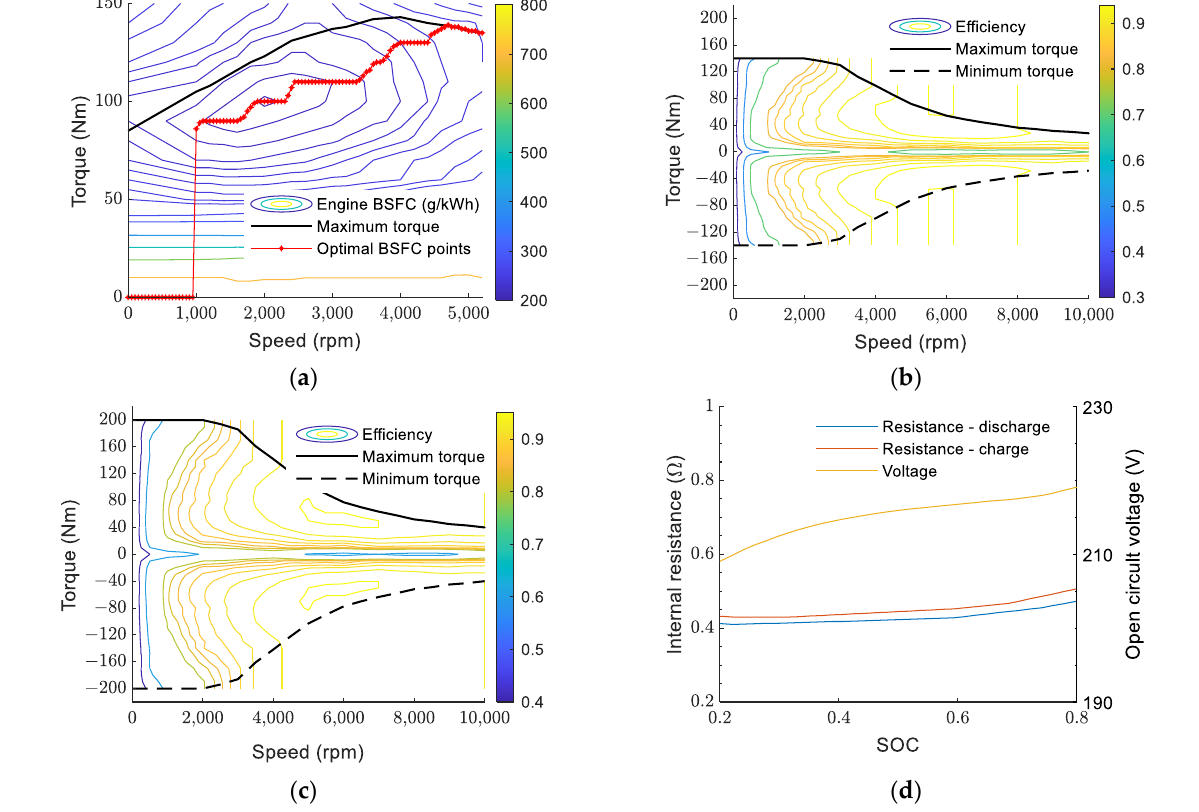
Figure 2. Component lookup tables for the powertrain: ( a ) engine, ( b ) MG1, ( c ) MG2, and ( d ) battery.